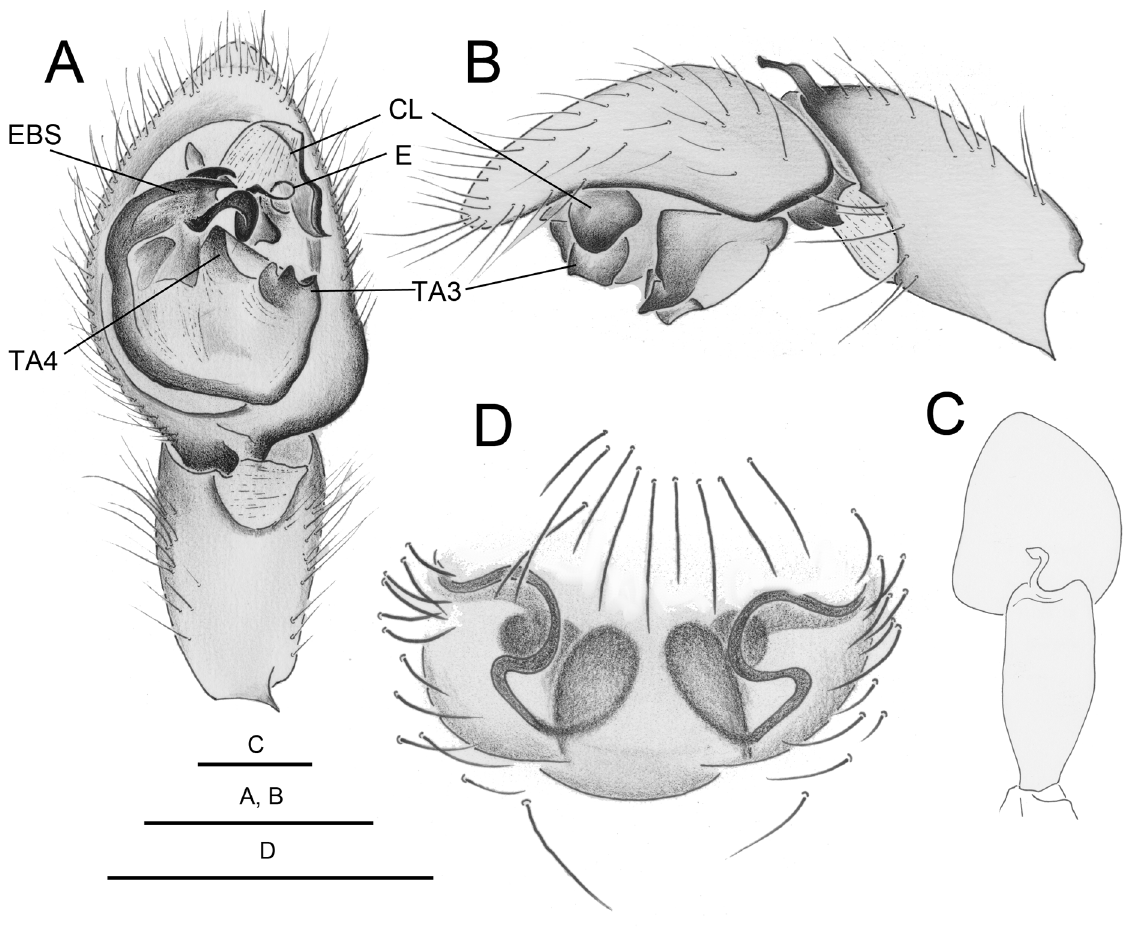
Fig. 7. Xevioso megcummingae sp. nov. A–C . Holotype, ♂ (RMCA_ARA_236654). D . Paratype, ♀ (RMCA_ARA_236655). A . Palp, ventral view. B . Palp, lateral view. C . Palp, dorsal view. D . Epigyne, TA3, TA4 = tegular apophyses 3 and 4. Scale bars: A–C = 500 μm; D = 100